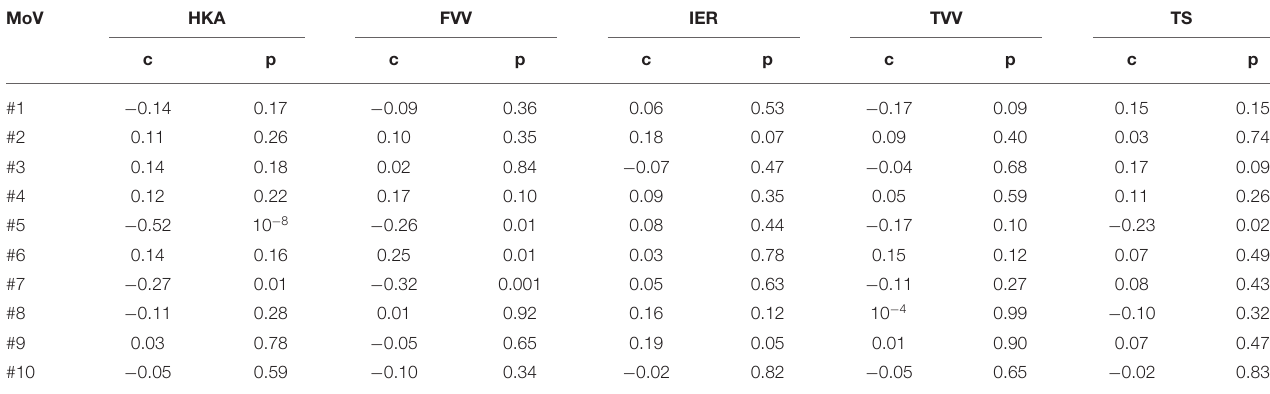
MoVs #5 and #7 feature significant correlation